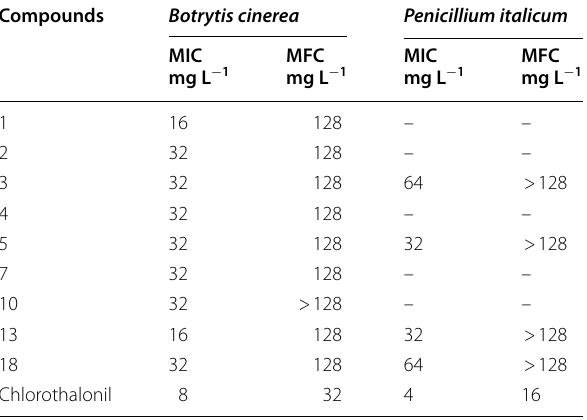
Table 1 The MICs and MFCs of the individual compounds of M. fortunei against spore germination of B. cinerea and P. italicum Compounds